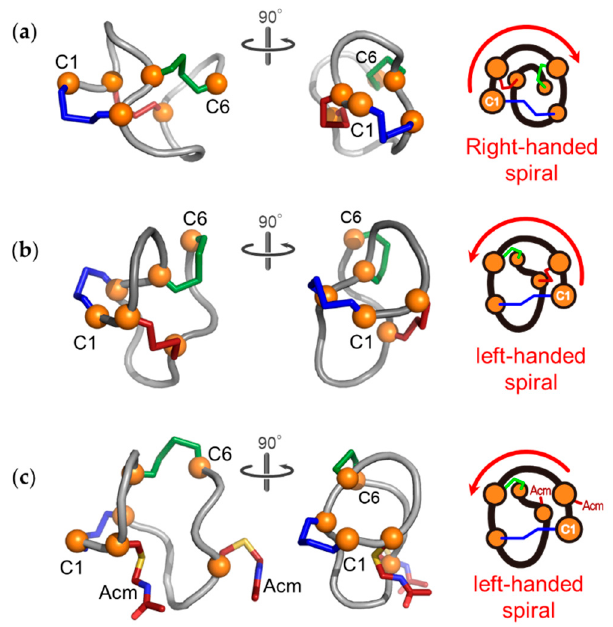
Figure 4. The schematic drawings ( left and middle ) of ( a ) the native form, ( b ) topological isomer, and ( c ) Acm 2 -precursor peptide of ST h (6–18). Their backbone structures were illustrated by cartoon representations. The orange spheres represent the C α of Cys. The disulfide linkages, C1–C4, C2–C5, and C3–C6, were illustrated by stick representation colored by blue , red , and green , respectively. Schematic drawings of each structure ( right ) showed the right or the left-handed spiral of their backbone when seen from the N- to the C-terminal.